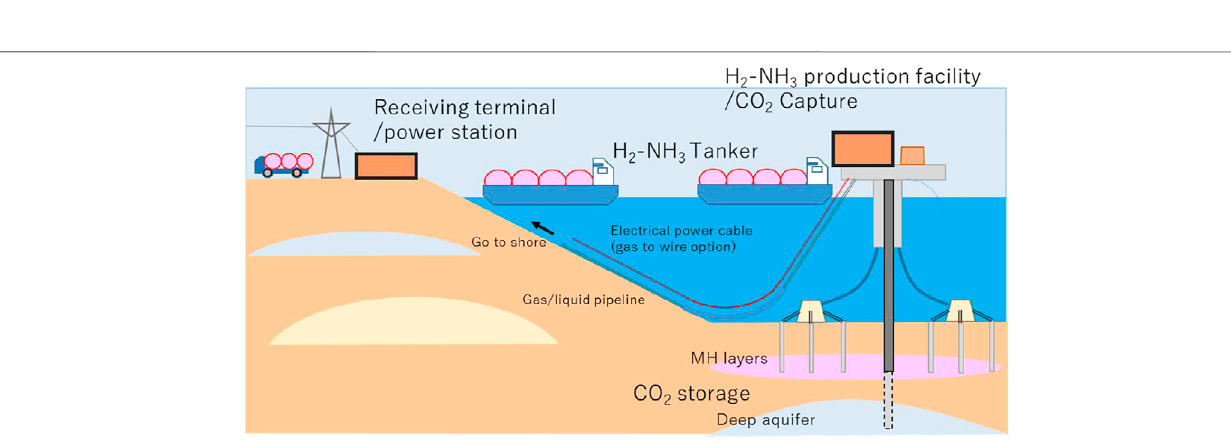
Frontiers in Energy Research |